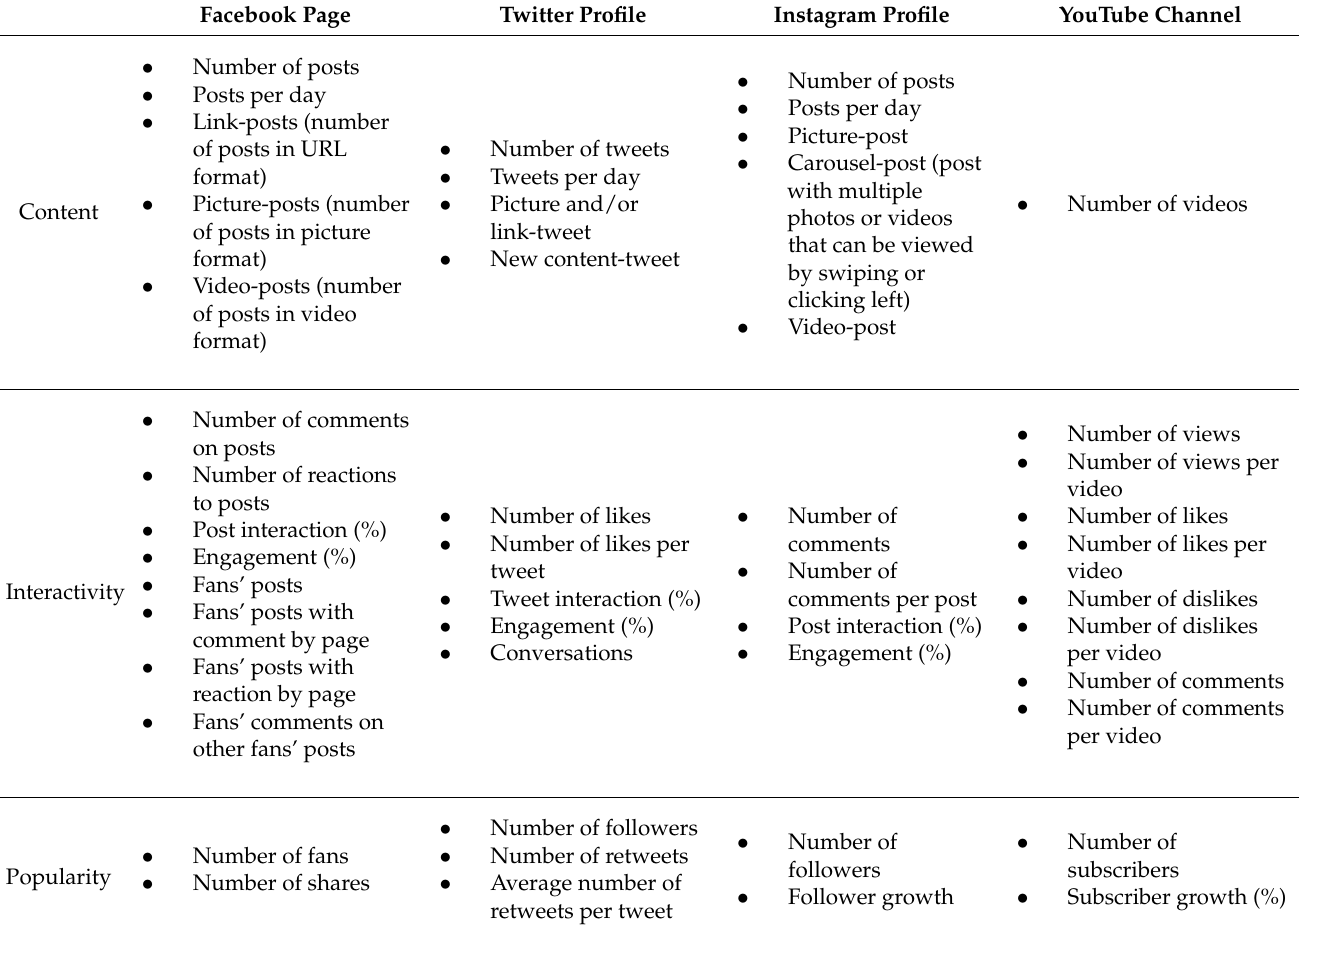
Table 2. List of metrics per